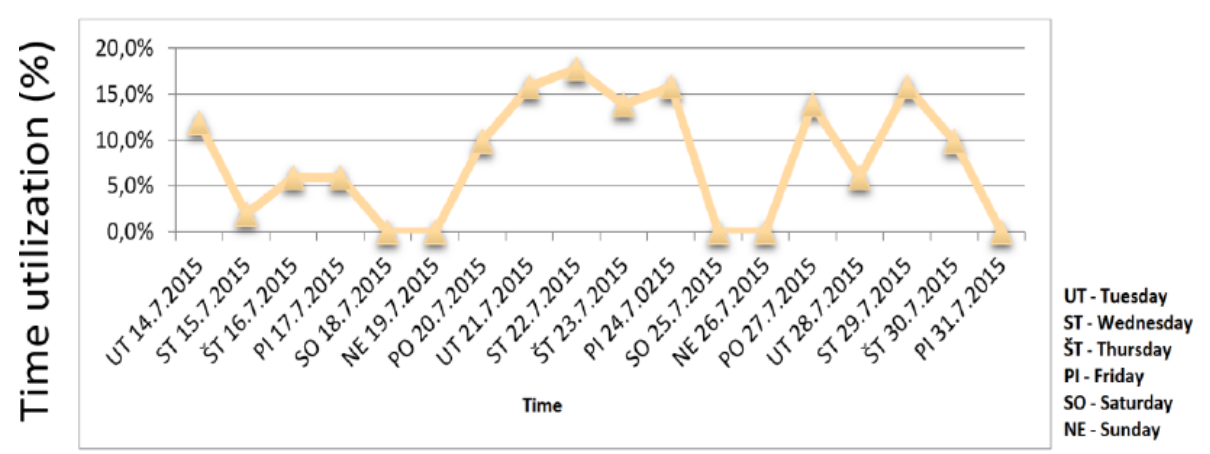
Figure 12: Time utilization of